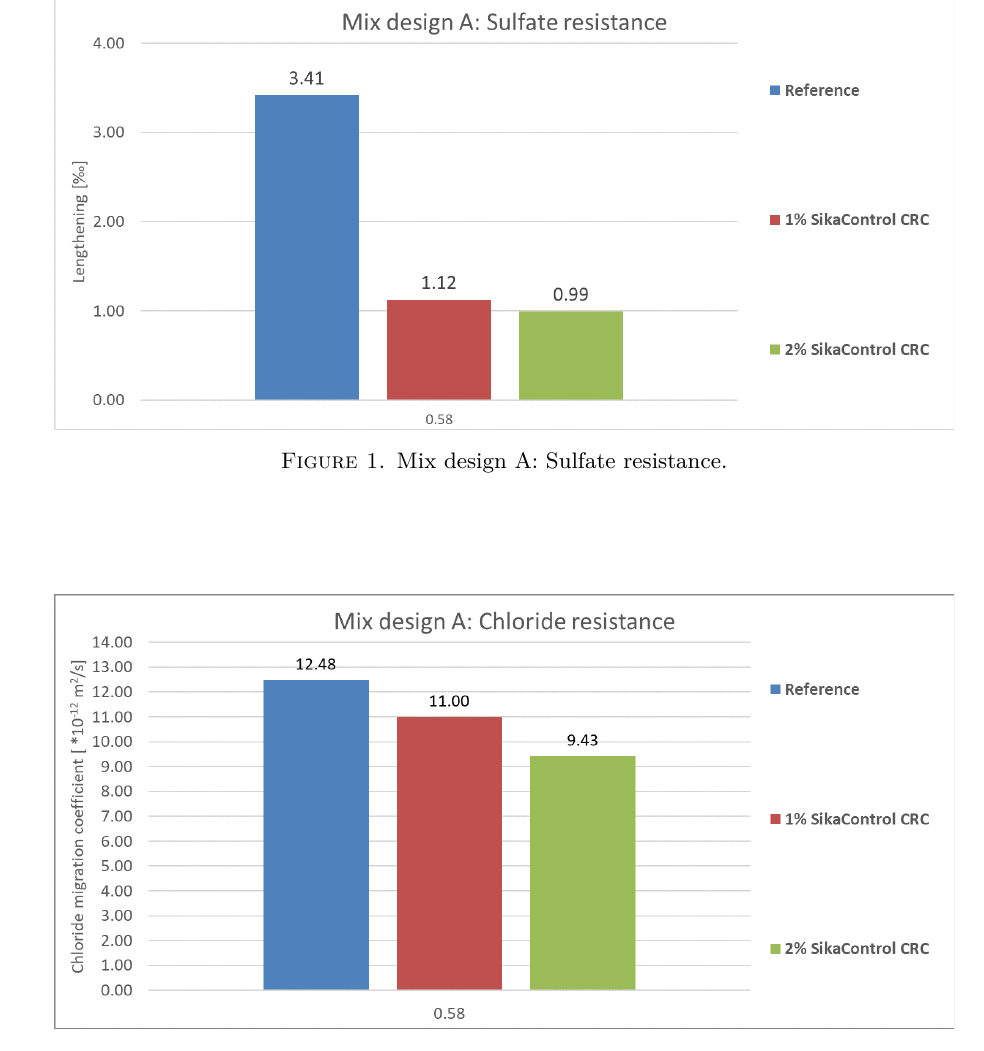
Figure 2. Mix design A: Chloride resistance.